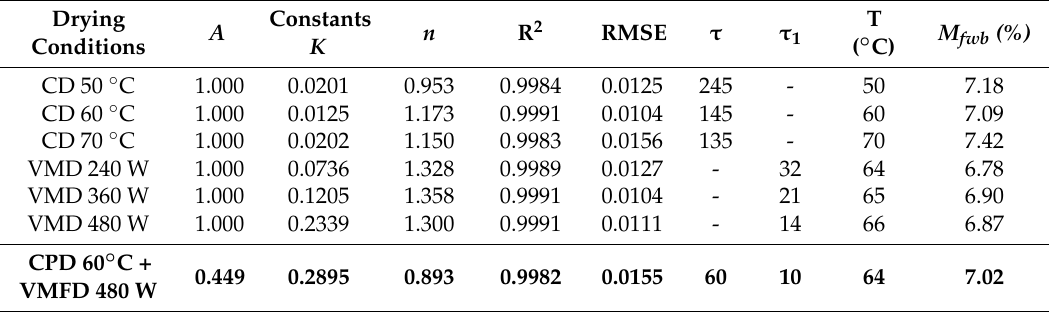
Figure 1. ( a ) Drying kinetics of true lavender leaves samples processed using VMD at magnetron powers 240, 360 and 480 W; ( b ) Drying kinetics of true lavender leaves samples processed using CD at temperatures of 50, 60 and 70 °C; ( c ) Drying kinetics of true lavender leaves samples processed using VMFD at 480 W after CPD at temperature 60 °C. Table 1. Final moisture content (M fwb ), maximum temperature of the sample T, convective drying time ( τ ), vacuum microwave drying time ( τ 1 ), and constants A, k and n of the modified Page model describing the drying kinetics.